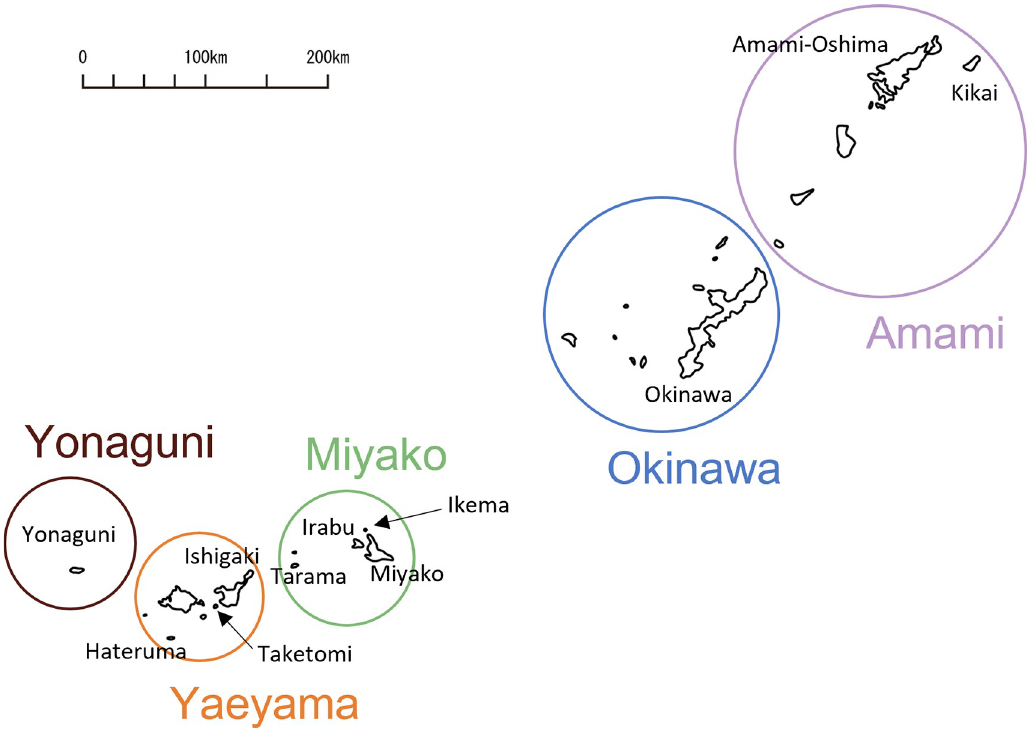
Fig 1. Map of the Ryukyu Archipelago. Five languages (dialects) are spoken in five regions (Amami, Okinawa, Miyako, Yaeyama and Yonaguni). The locations of the eleven islands for which either or both linguistic and genetic data were available are also indicated. Created based on a map from https://www.freemap.jp/ under a CC BY license, with permission from Keisuke Inoue, original copyright